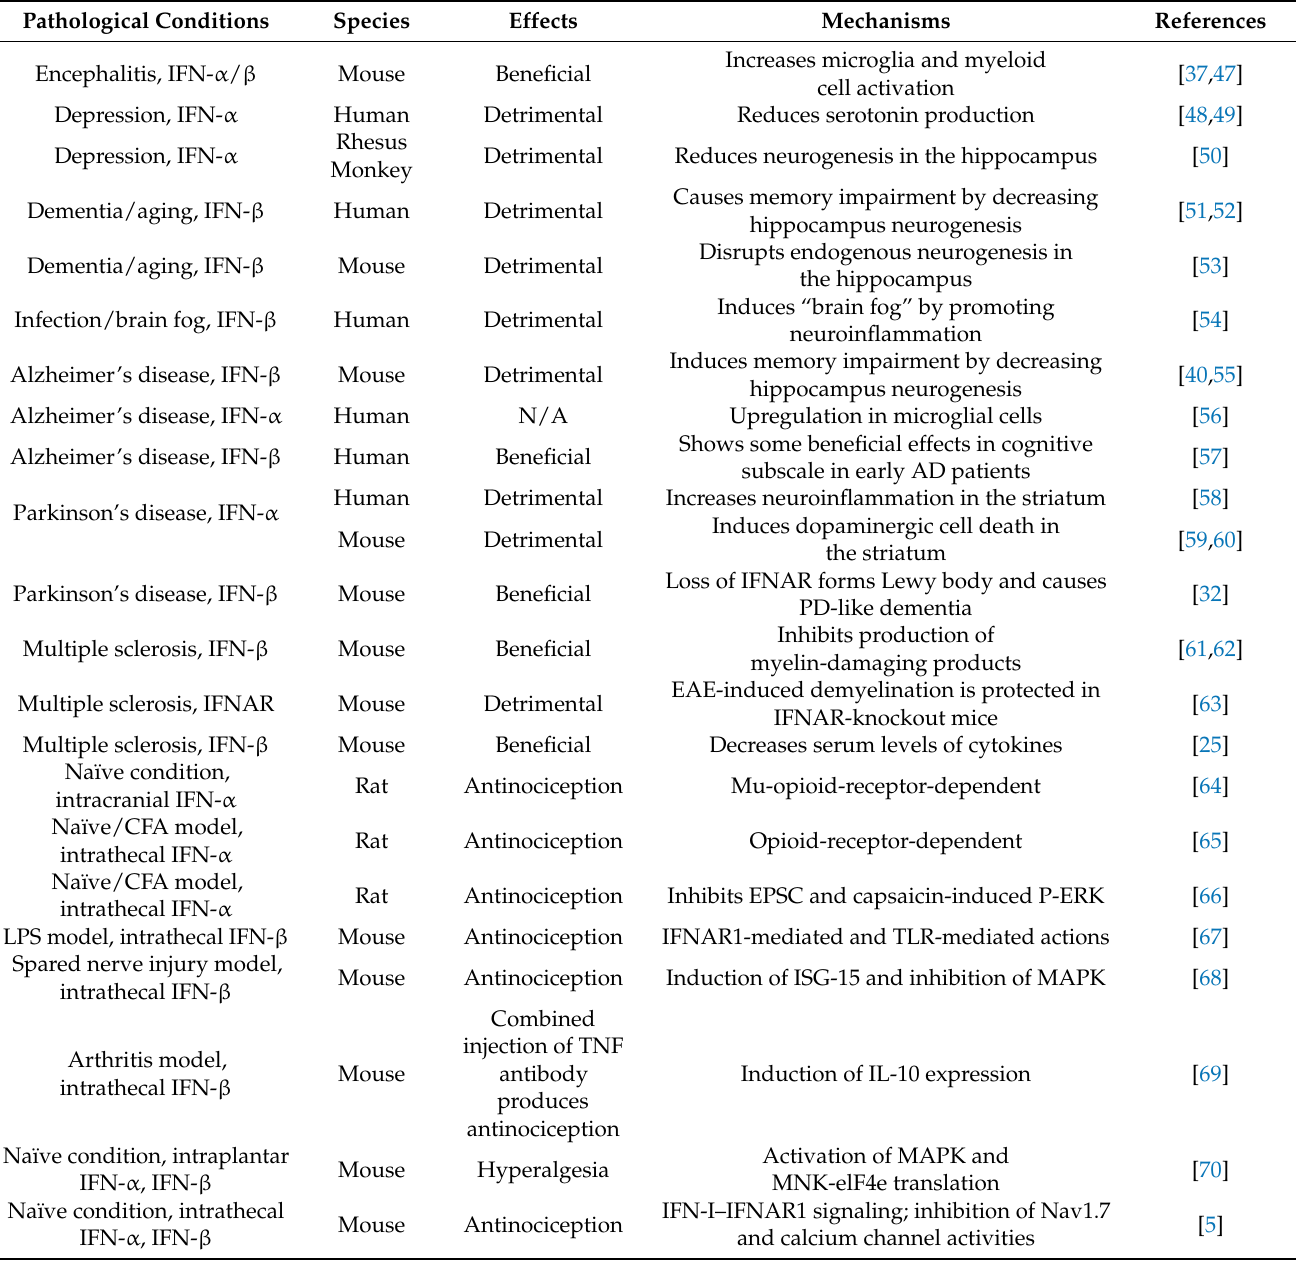
Table 1. Roles of IFN- α and IFN- β in neurological diseases. IFN- α and IFN- β produce both beneficial and detrimental actions and may contribute to cognitive deficits (brain fog) in long-haul